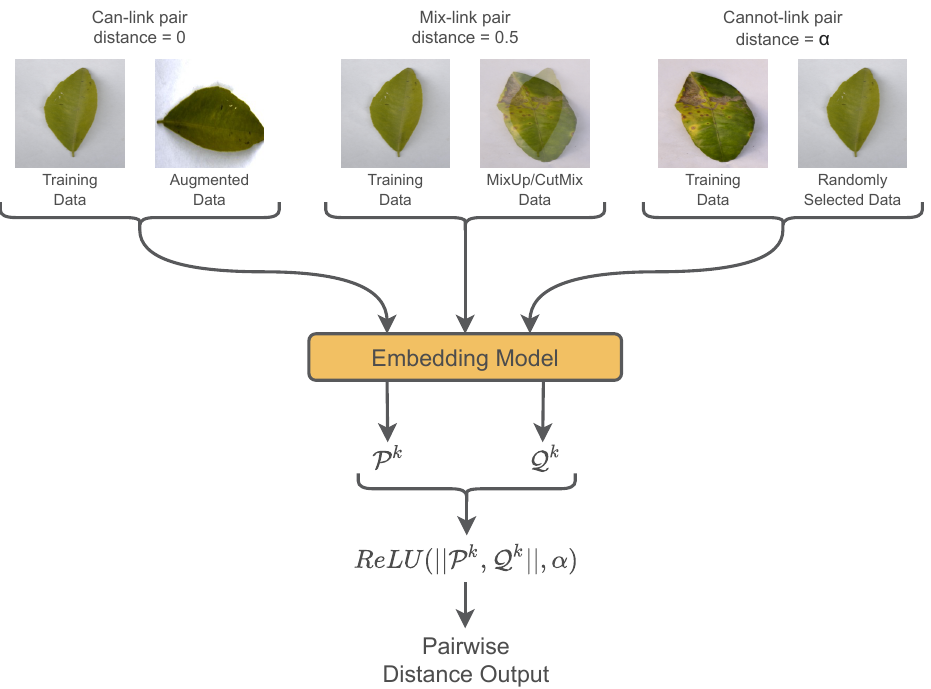
Figure 1. The AutoEmbedder architecture evenly receives three possible linkage constraints while training. The target of the model is to predict the accurate distance given the input image pairs. Through learning the similarity and dissimilarity, the model learns class discriminative features and generates clusterable